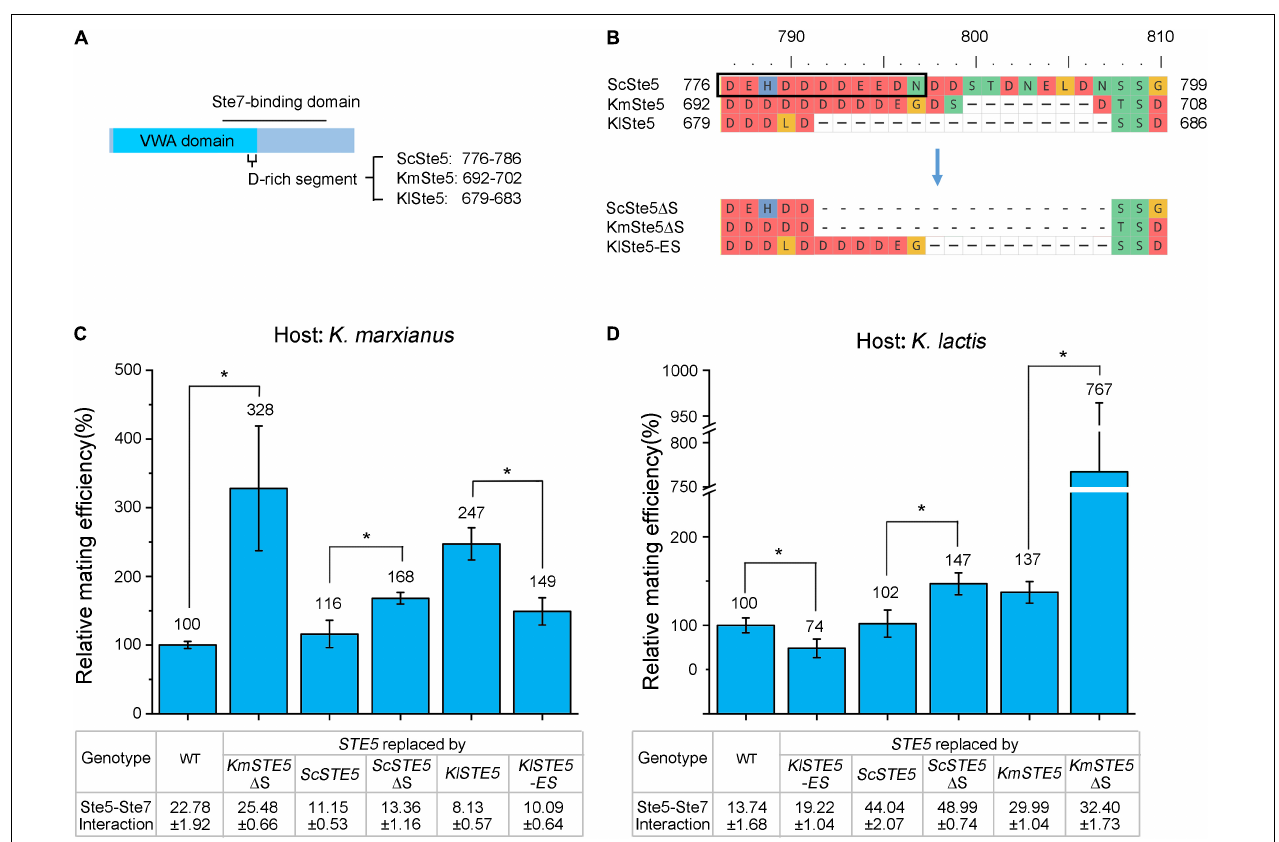
FIGURE 5 | The length of a negatively charged segment in the Ste7-binding domain of Ste5 is negatively correlated with the mating efficiency in K. marxianus and K. lactis . (A) Schematic representation of the position of the negatively charged segment in Ste5. (B) Alignment of regions around the negatively charged segment in ScSte5, KmSte5 and KlSte5. The segment in ScSte5 was indicated by a box. The alignment of mutant segments were shown below. (C,D) Relative mating efficiency of cells carrying mutant segment. LHP506, LHP507, LHP564, LHP702, LHP1043 ∼ LHP1045 were subjected to the assay of K . marxianus (C) . LHP570, LHP571, LHP707, LHP711, LHP1046 ∼ LHP1048 were subjected to the assay of K . lactis (D) . Value represented mean ± SD from three biological repeats (* p < 0.05). The strength of interaction was measured as Figure 4A and the value represented the mean ± SD from three different